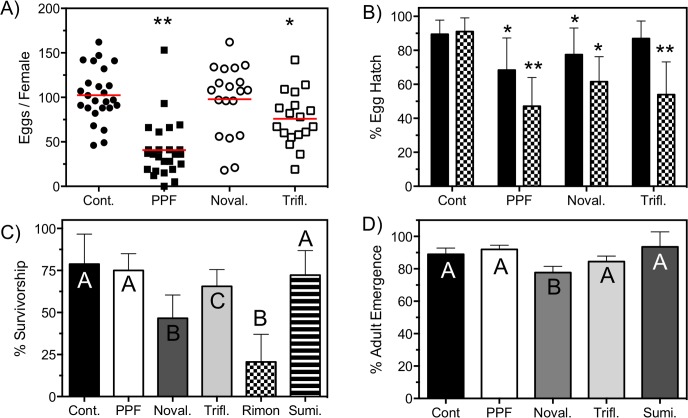
Influence on fecundity and larval survivorship after adult exposure to IGRs.A) Total number of eggs laid per female 72 hours after adult contact exposure to IGRs immediately after blood feeding. Control treatment was netting treated with acetone only. Each data point represents the egg output of an individual mosquito. Red bars indicate the median number of eggs laid for each treatment. Asterisks represent statistical significance (P<0.05) when compared to the control (solvent only) treatment. B) Percent hatch of the eggs. Solid bars represent the mean % egg hatch in habitats that were contaminated by the adult mosquito during oviposition (horizontal transfer) whereas the checkered bars represent egg hatch of eggs laid in water contaminated with an IGR at the IE50 concentration. Bars represent a mean % hatch (n = 25) and error bars represent SEM. Asterisks represent statistical significance (* P<0.05, **P<0.01) when compared to the control treatment for each group, horizontal transfer and IGR treated water. C) % survivorship of larvae hatched from a habitat that was oviposited in by adults treated with IGRs. Mortality was measured by counting number of alive 1st-instar larvae compared to 2nd-instar larvae. Bars represent average survivorship (n = 25) and error bars represent SEM. D) % emergence of ultimate instar larvae added into oviposition sites that had eggs laid. Bars represent means (n = 4, 10 mosquitoes per rep) and error bars represent SEM. For all panels, letters indicate statistical categorization of the means as determined by a one-way ANOVA with a multiple comparisons test (P < 0.05). Bars not labeled by the same letter as the control bar represents statistical significance when compared to the control value (P<0.05).